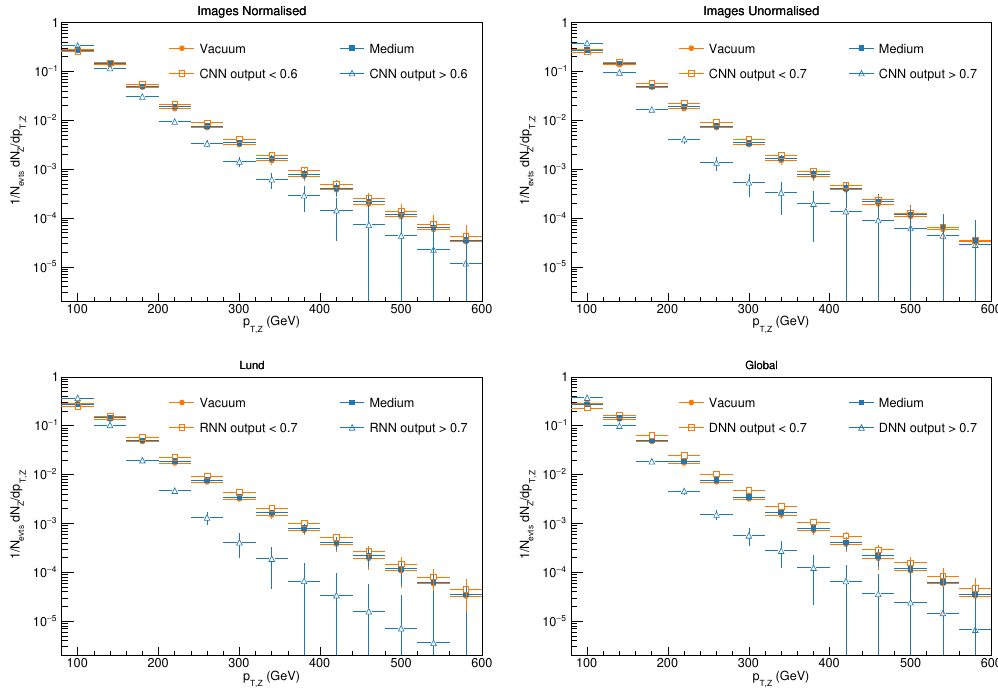
Figure 12 . Transverse momentum spectra of the reconstructed Z -boson p T,Z , for the different Deep Learning architectures. Monte Carlo truth from JEWEL+PYTHIA is provided in solid symbols for the Vacuum and Medium samples and a subset of events selected by the DL discriminant appears in open symbols. The DL output selection employed to identify vacuum-like jets (open blue) and medium-like jets (open orange) is made explicit in the legend of each